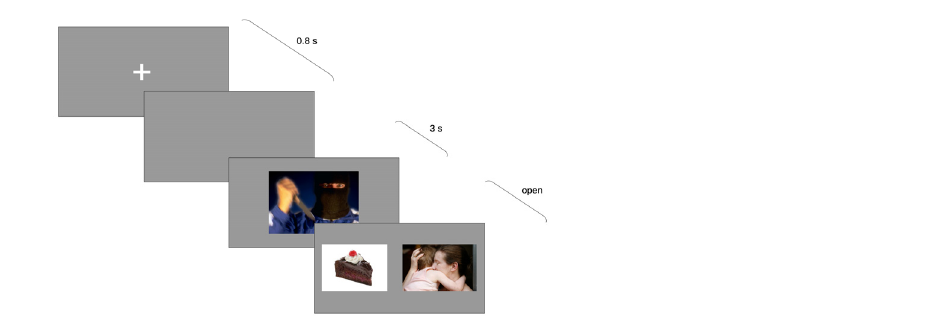
Figure 1. Experimental task used in the study, showing the progression of the visual stimuli in time.